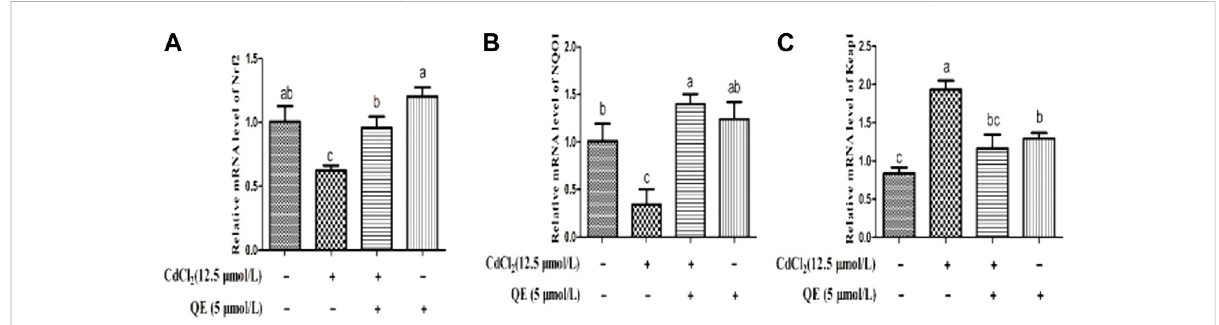
FIGURE 4 Effects of QE on the mRNA expression of Cd-induced the Nrf2 signal pathway related genes in BRL-3A cells. Relative mRNA levels of Nrf2 (A) , NQO1 (B) , and Keap1 (C) in BRL-3A cells. Data are expressed as the mean ± SEM, and data with different letters (a, b, and c) represent signi fi cant differences ( p < 0.05) among different treatments.